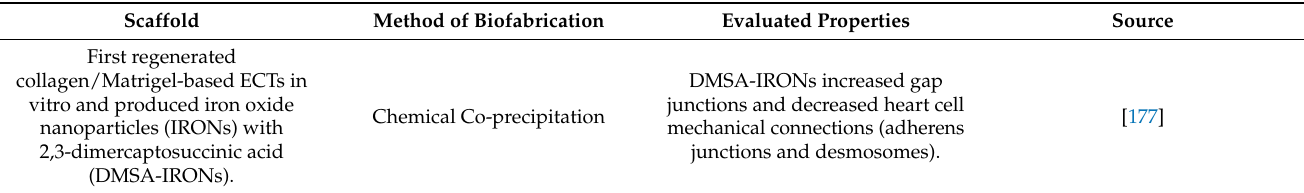
vitro and produced iron oxide nanoparticles (IRONs)